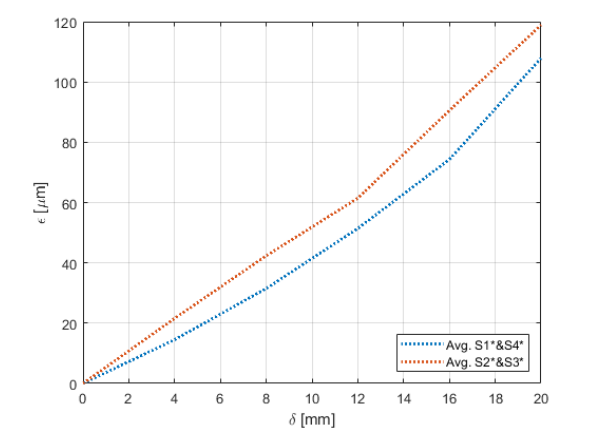
Figure 13. Strain trend in the bottom section of the wing undergoing bend-up with respect to deflection due to